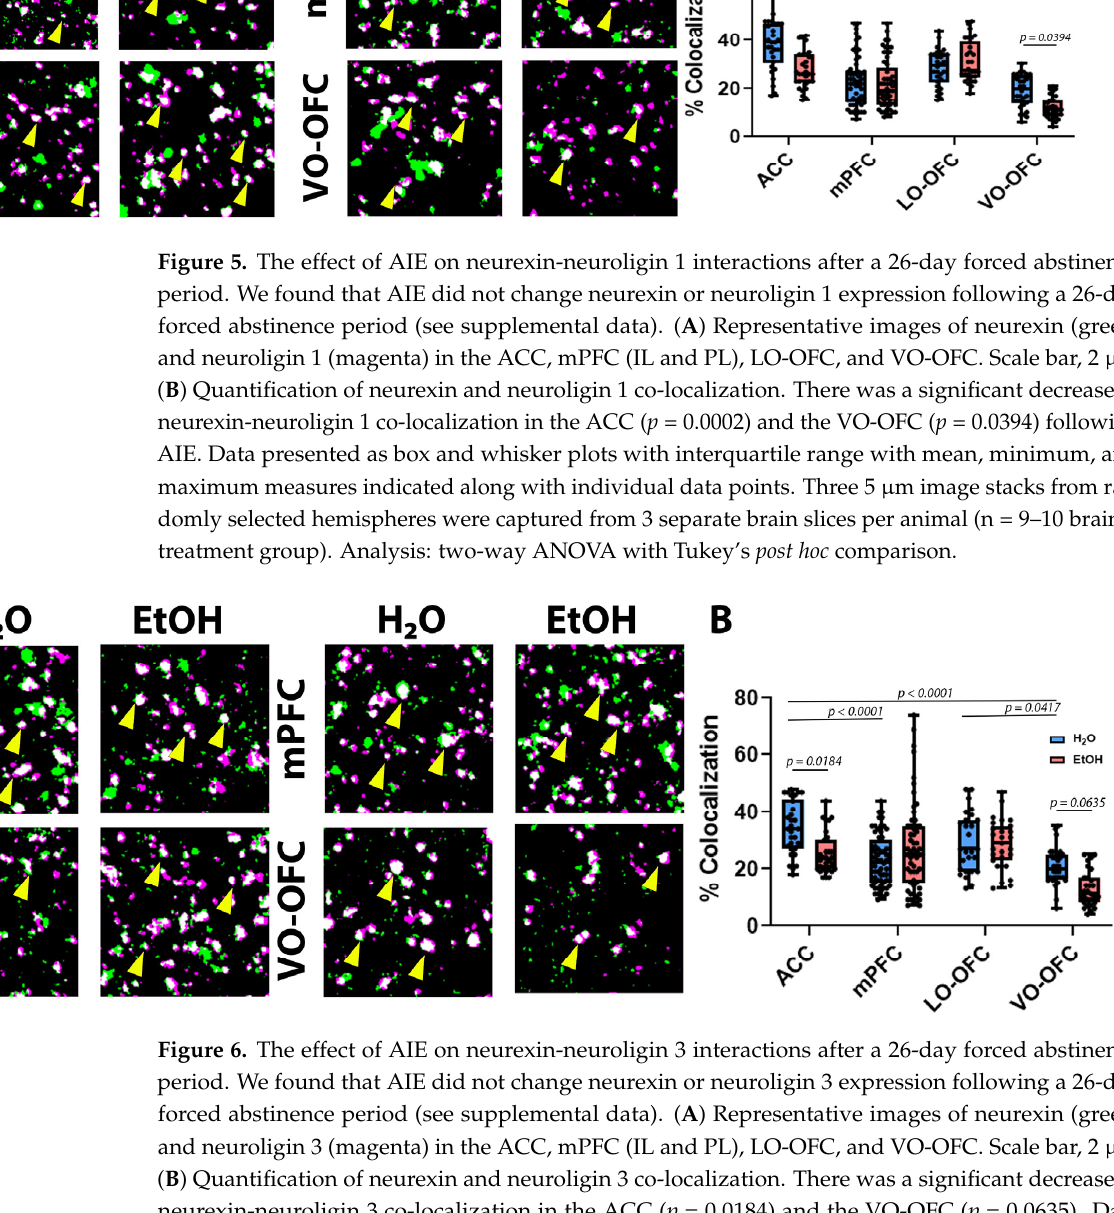
Figure 5. The effect of AIE on neurexin-neuroligin 1 interactions after a 26-day forced abstinence period. We found that AIE did not change neurexin or neuroligin 1 expression following a 26-day forced abstinence period (see supplemental data). ( A ) Representative images of neurexin (green) and neuroligin 1 (magenta) in the ACC, mPFC (IL and PL), LO-OFC, and VO-OFC. Scale bar, 2 μ m. ( B ) Quantification of neurexin and neuroligin 1 co-localization. There was a significant decrease in neurexin-neuroligin 1 co-localization in the ACC ( p = 0.0002) and the VO-OFC ( p = 0.0394) following AIE. Data presented as box and whisker plots with interquartile range with mean, minimum, and maximum measures indicated along with individual data points. Three 5 μ m image stacks from randomly selected hemispheres were captured from 3 separate brain slices per animal (n = 9–10 brains/treatment group). Analysis: two-way ANOVA with Tukey’s post hoc comparison.